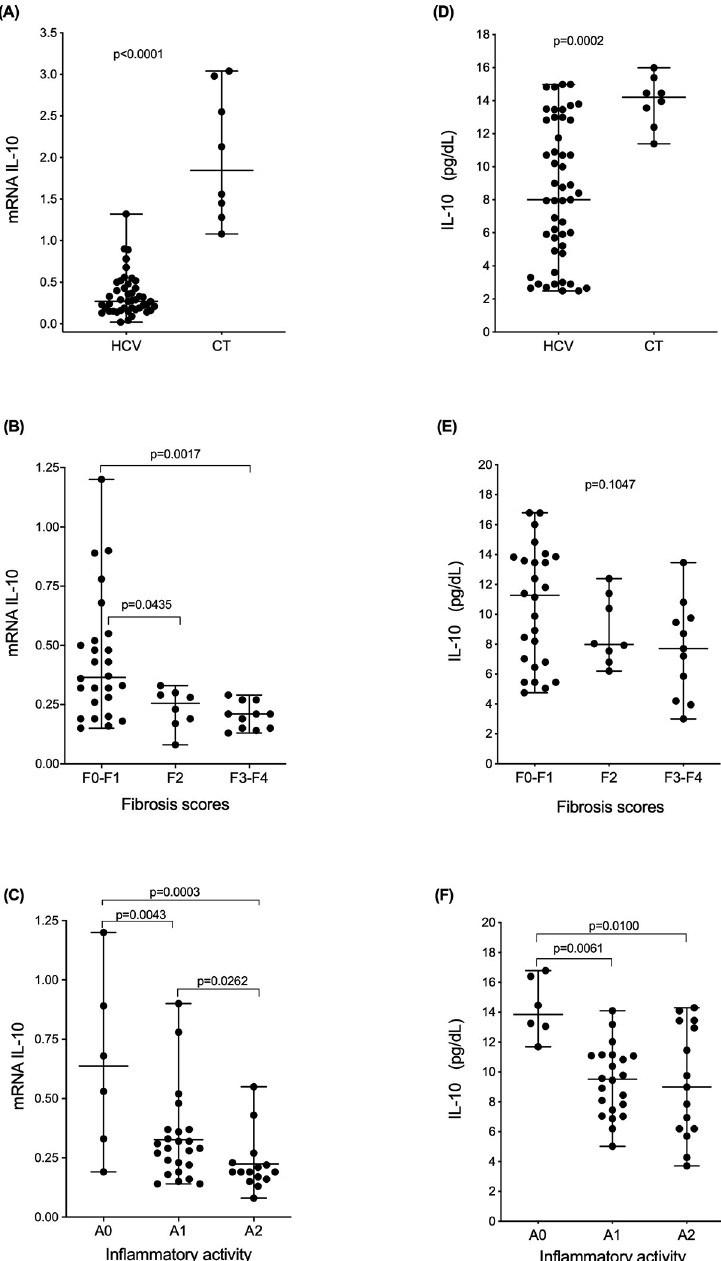
Fig 1. IL10 mRNA and plasma IL-10 levels according to the clinical condition of the liver. A-C: Intrahepatic IL10 expression between the HCV and control (CT) patients with different fibrosis scores and with different necroinflammatory activity levels (A: Mann-Whitney test; B and C: Kruskal-Wallis test). D-F: Plasma IL-10 concentrations between HCV and CT patients with different fibrosis scores and be with different necroinflammatory activity scores (D: Mann-Whitney test; E and F: Kruskal-Wallis